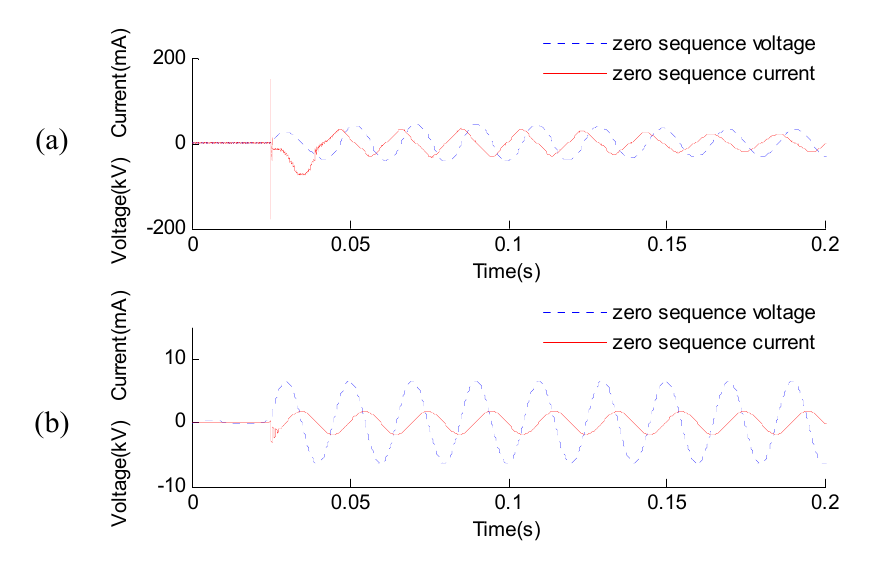
Figure 15. ( a ) Zero sequence voltage and current of fundamental ferroresonance; ( b ) Zero sequence voltage and current of single